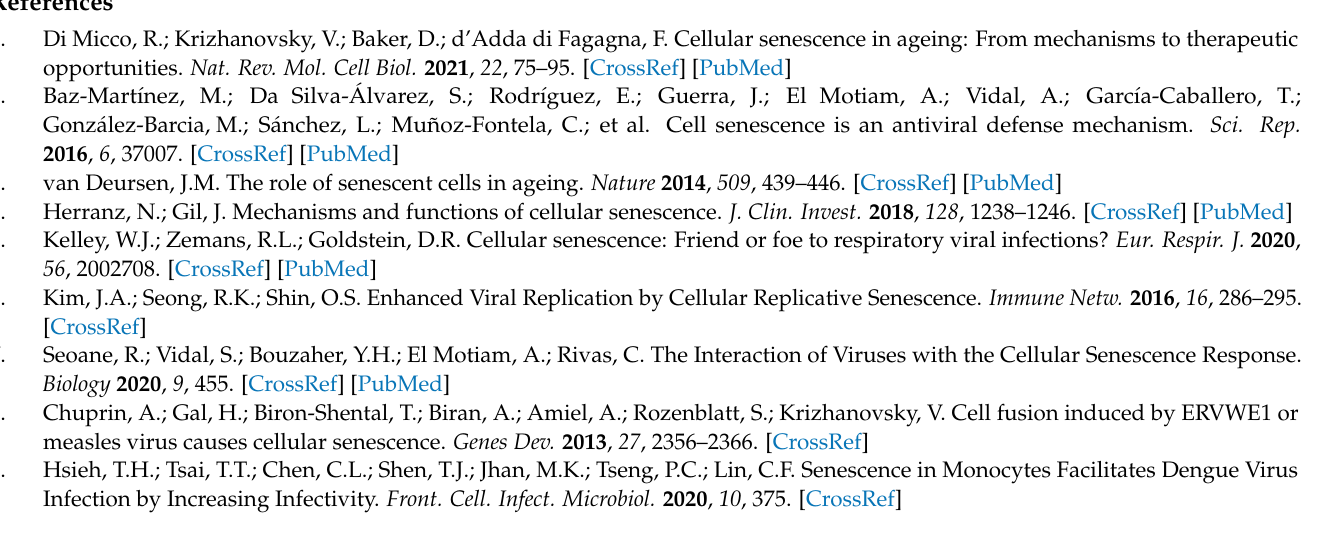
Figure S5: MCPyV LT induces p21-dependent senescence; Figure S6: MCPyV LT expression induces G2 cell cycle arrest; Figure S7: MCPyV LT negatively regulates cell growth by inducing cellular senes- cence; Figure S8: Differential gene expression analysis; Figure S9: MCPyV induces p21-dependent senescence; Figure S10: Senolytic treatment inhibits MCPyV-induced cellular senescence; Figure S11: MCPyV minicircle genome; Table S1: Primers used in this study; Supplementary Dataset